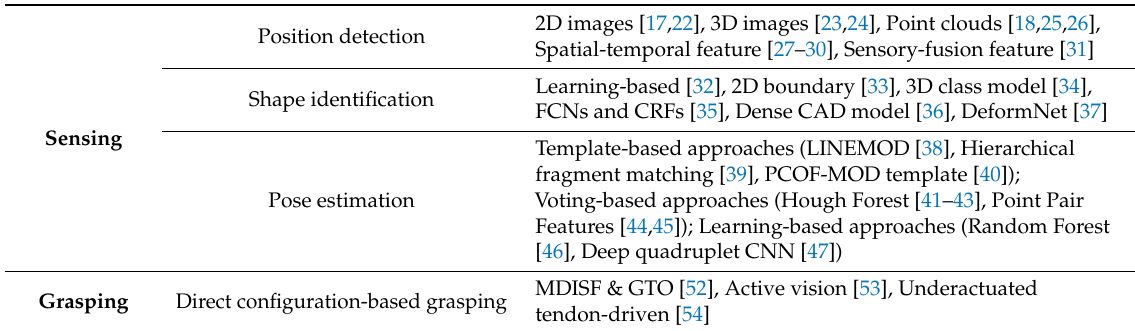
Table 1. Feature sensing and robotic grasping for geometric-uncertain